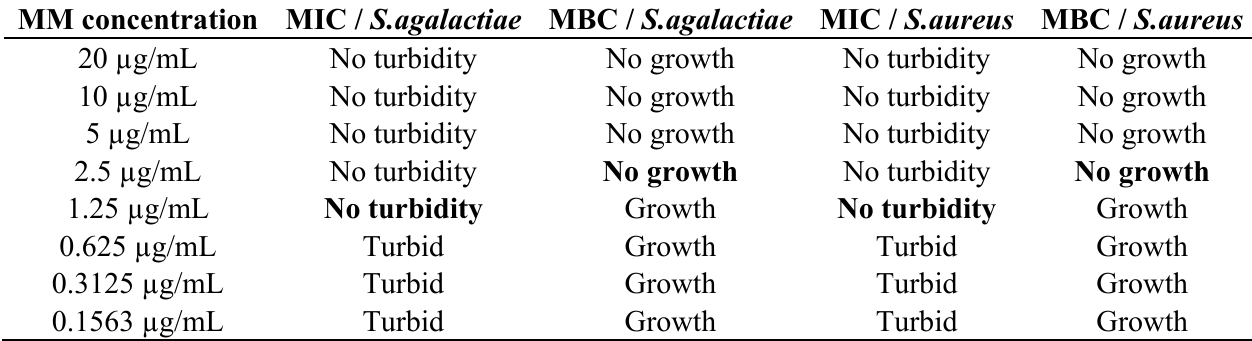
Table 3. Minimal inhibitory concentrations (MIC) and Minimal bactericidal conentrations (MBC) of MM’s ethanol extract against S. agalactiae and S. aureus